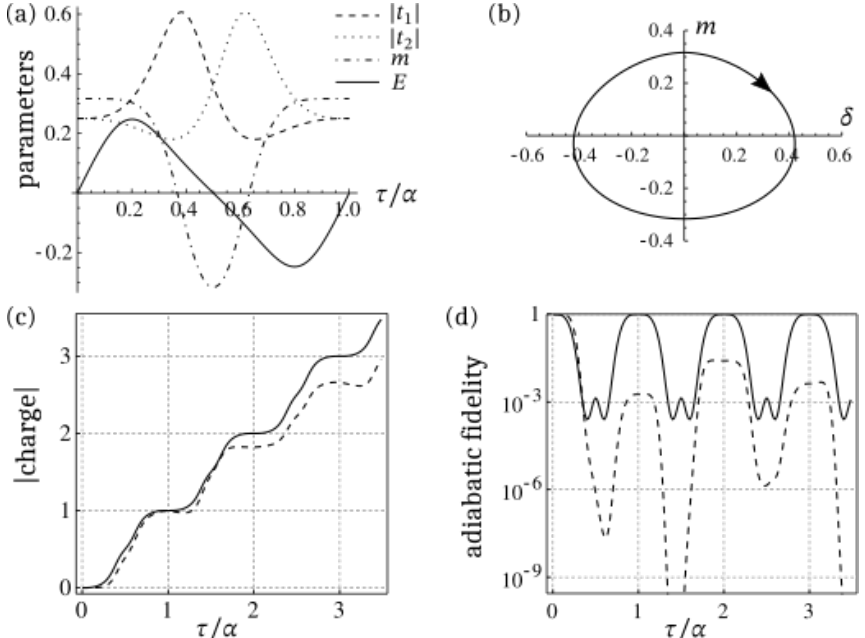
Figure 2: Comparison of an ideal and a non-ideal pumping protocols for the driving parameters α = 0.09 and µ = 3.5, and the system size N = 50. The non-ideal protocol is obtained from the ideal one by suppressing the electric field pulse. Panel (a): Time-dependent tight-binding parameters and the electric field E = ˙ θ for the ideal protocol. Panel (b): Projection of the driving path onto the ( δ , m ) plane. Panel (c): Pumped charge as a function of time for the ideal (solid line) and non-ideal (dashed line) protocols. Panel (d): Adiabatic fidelity for the ideal (solid line) and non-ideal (dashed line)